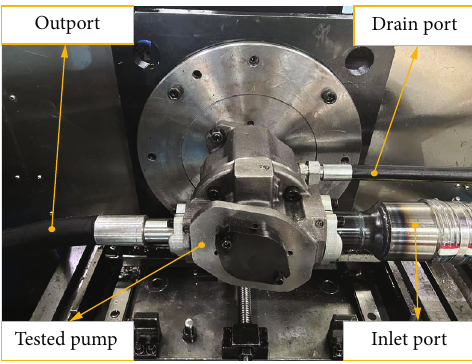
Figure 9: The tested axial plunger pump.